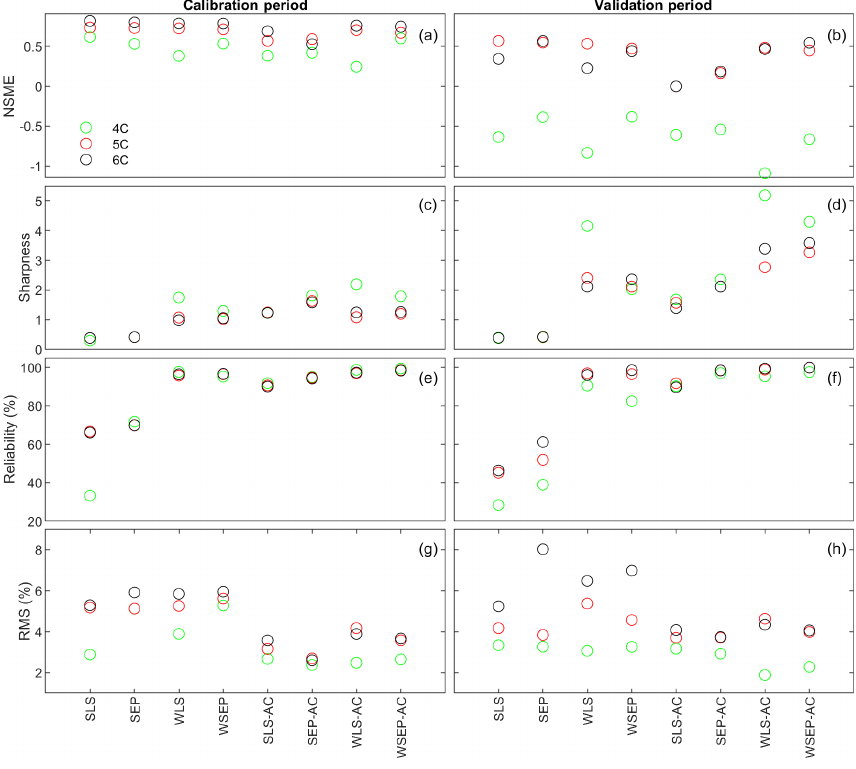
Figure 9. (a, b) Nash–Sutcliffe model efficiency (NSME), (c, d) sharpness, (e, f) predictive coverage, and (g, h) relative model score for measuring predictive performance of the three soil respiration models and the eight data models during the calibration and cross-validation periods. The statistics are evaluated from the prediction ensembles generated to consider parametric uncertainty of not only the soil respiration models but also the data